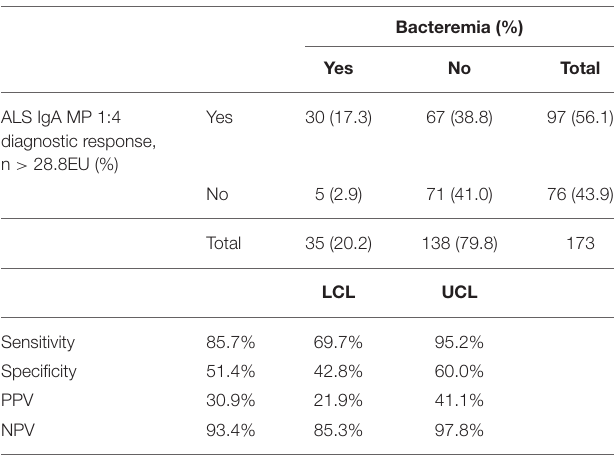
TABLE 6 | Contingency table of Nepal field study anti-MP IgA ALS results (1:4 concentration) and blood-culture confirmed